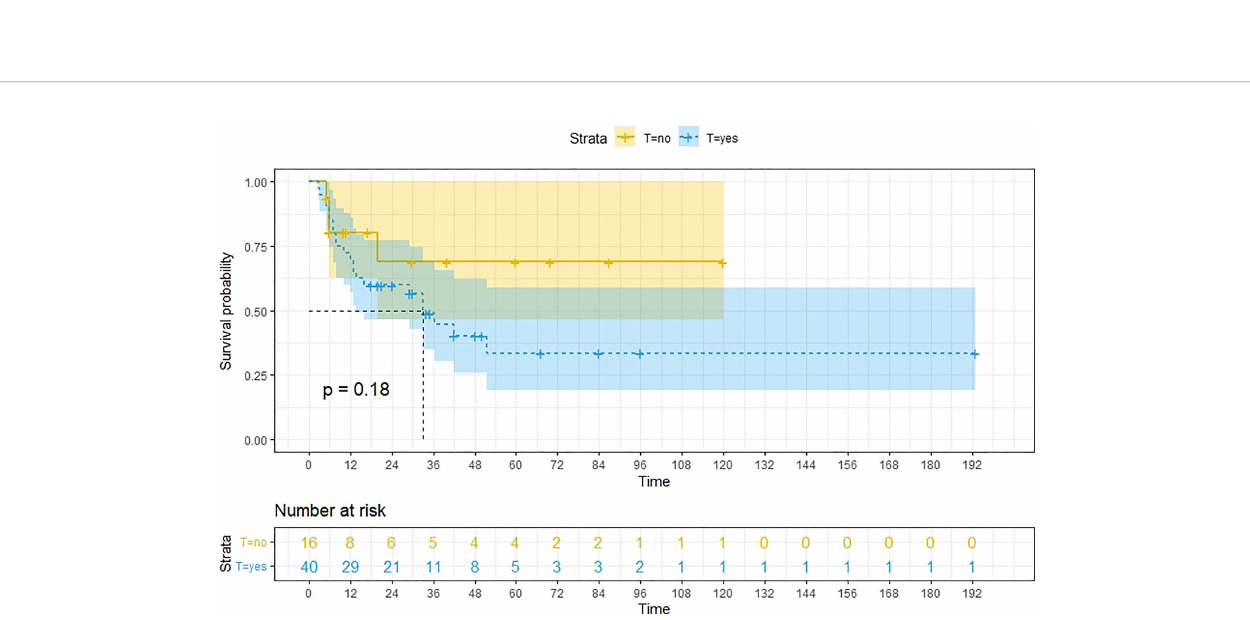
FIGURE 9 | Kaplan-Meier survival curves for OS in patients of RH-based surgery with and without other treatments. Survival rates at the 24m, 36m, 48m and 60m time points were signi fi cantly higher for patients who did not add other treatment modalities than for those who